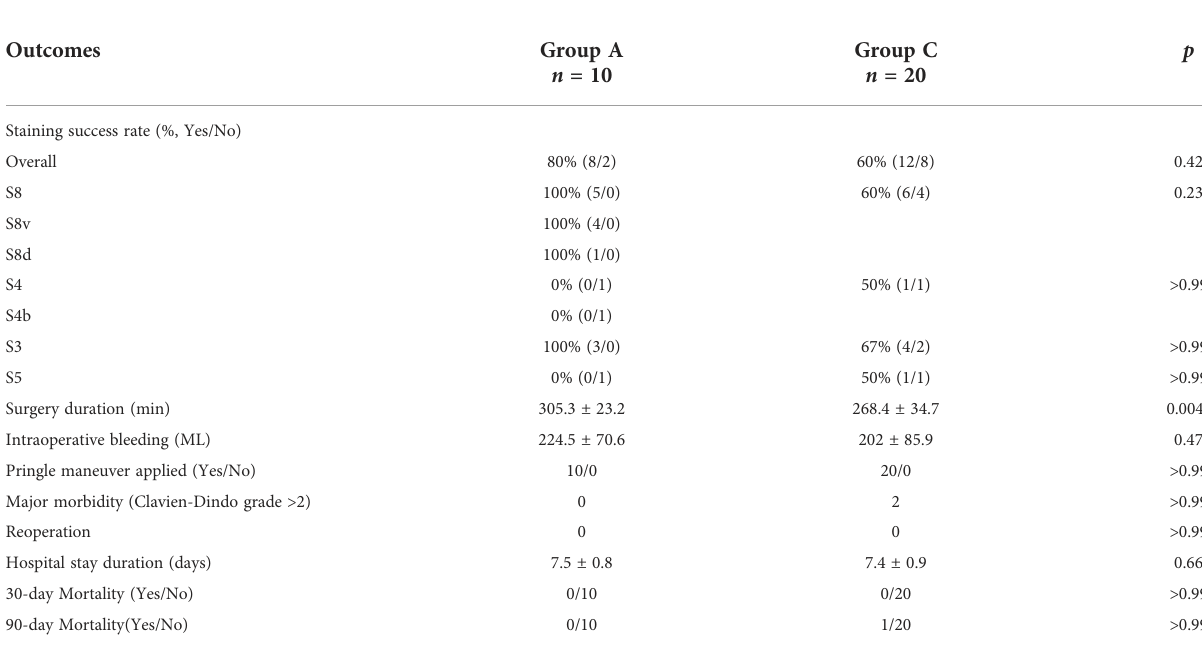
TABLE 2 Surgical outcome in Group A and Group C. Outcomes Group